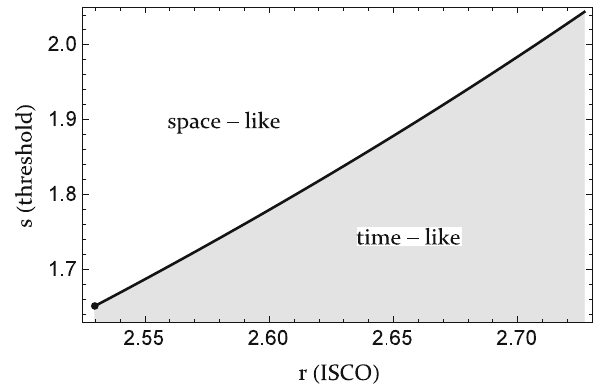
Fig. 4 The same as Fig. 3 for the case of a Schwarzschild black hole with quintessence. The solid line corresponds to the values of the quintessence parameter in the range c ∈ [ 0 , 0 . 043 ]